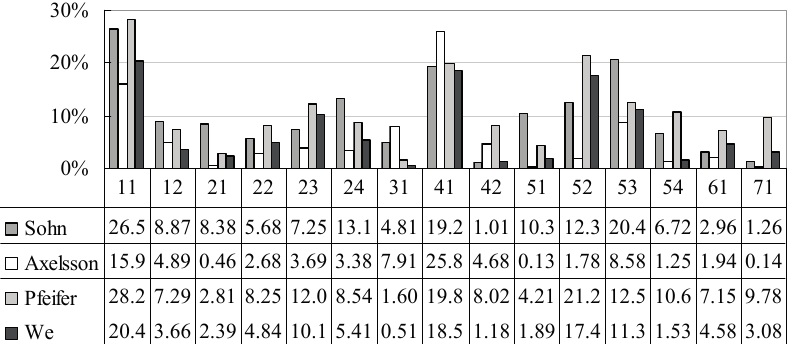
Figure 6. Comparison of type I errors in the filtered sample